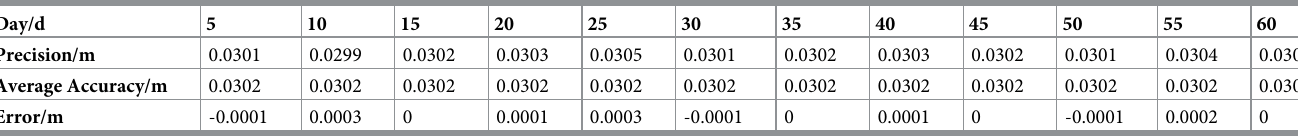
Table 4. Change in positioning accuracy over